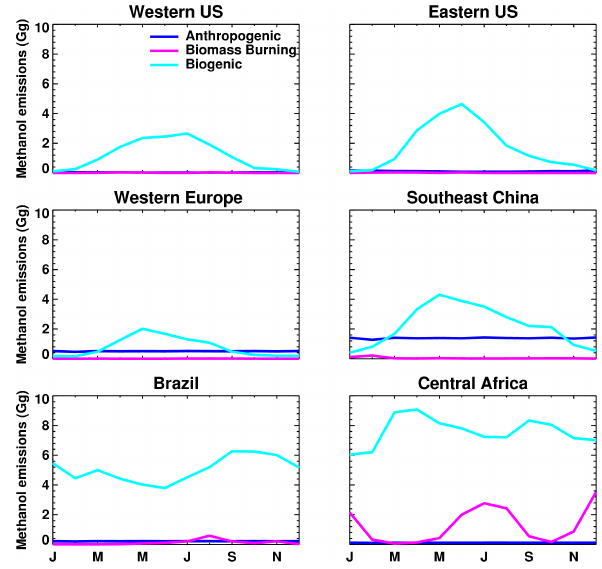
Fig. 11. Seasonality of methanol emissions from anthropogenic (blue), biomass burning (pink), and biogenic sources (cyan) in the GEOS-Chem a priori simulation for the regions in Fig.